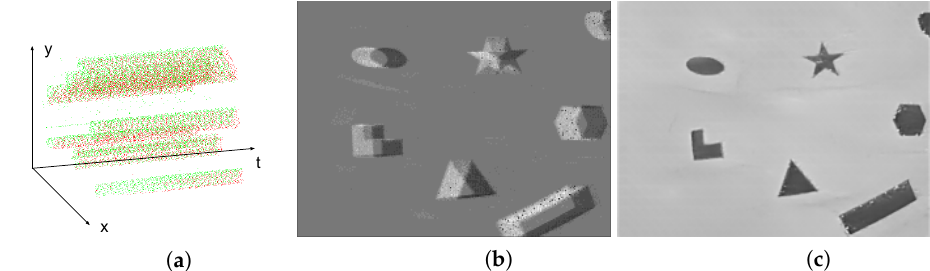
Figure 1. The different approaches to visualize a sample event stream. ( a ) Projecting events to a spatio- temporal space. ( b ) Calculating the number of events for each pixel in one second. ( c ) Reconstructing a grayscale image from a stream of